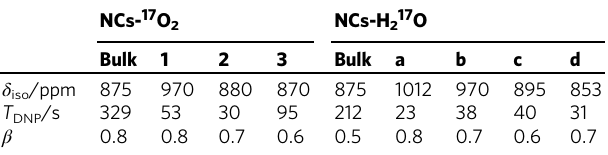
Table 3 The build-up time ( T DNP ) and stretching exponent ( β ) of different peaks extracted from the 17 O direct DNP saturation recovery build-up curves shown in Fig.